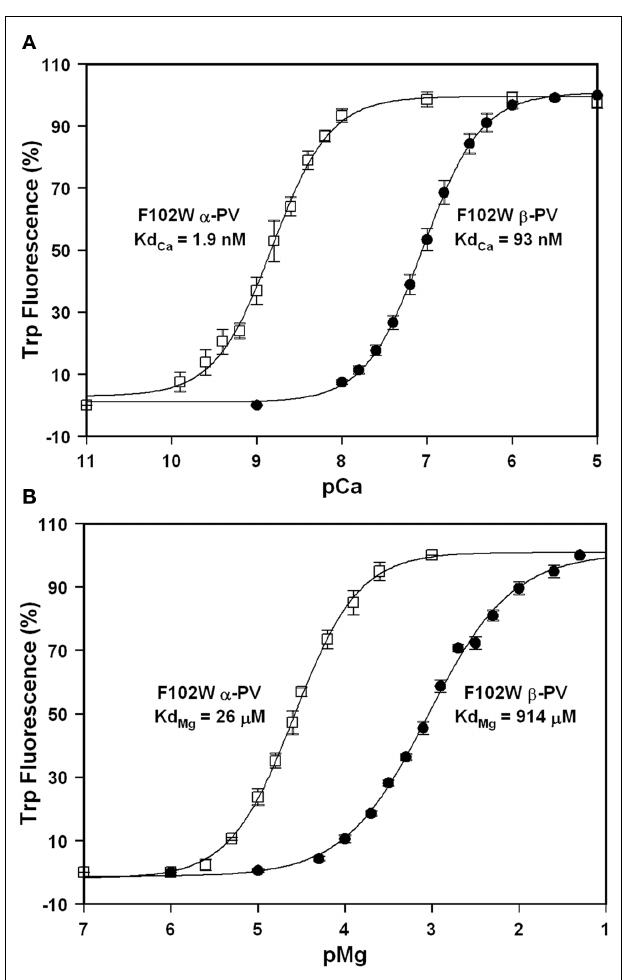
FIGURE 2 | Ca 2 + and Mg 2 + binding to the F102W α -PV and F102W β -PV. (A) The Ca 2 + dependent increase inTrp fluorescence is shown as a function of − Log[Ca 2 + ] (pCa) for F102W α -PV ( (cid:2) ) and F102W β -PV ( • ). Increasing concentrations of Ca 2 + were added to 1 μ M protein in 2ml of 200mM MOPS, 150mM KCl, 4mM EGTA, pH 7.0 at 35˚C.Trp fluorescence was monitored at 330nm with excitation at 295nm. Each data point represents the mean ± SE of at least three titrations. (B) The Mg 2 + dependent increase inTrp fluorescence is shown as a function of − Log[Mg 2 + ] (pMg) for F102W α -PV ( (cid:2) ) and F102W β -PV ( • ).The experimental conditions were the same as described for (A) .